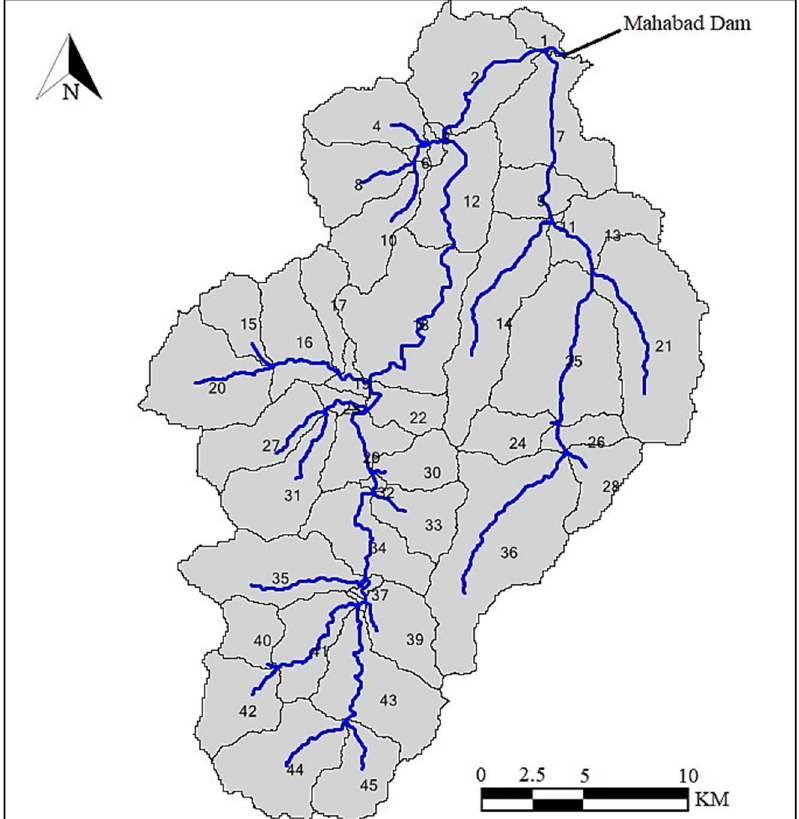
Figure 4. The delineated watershed in ArcSWAT.